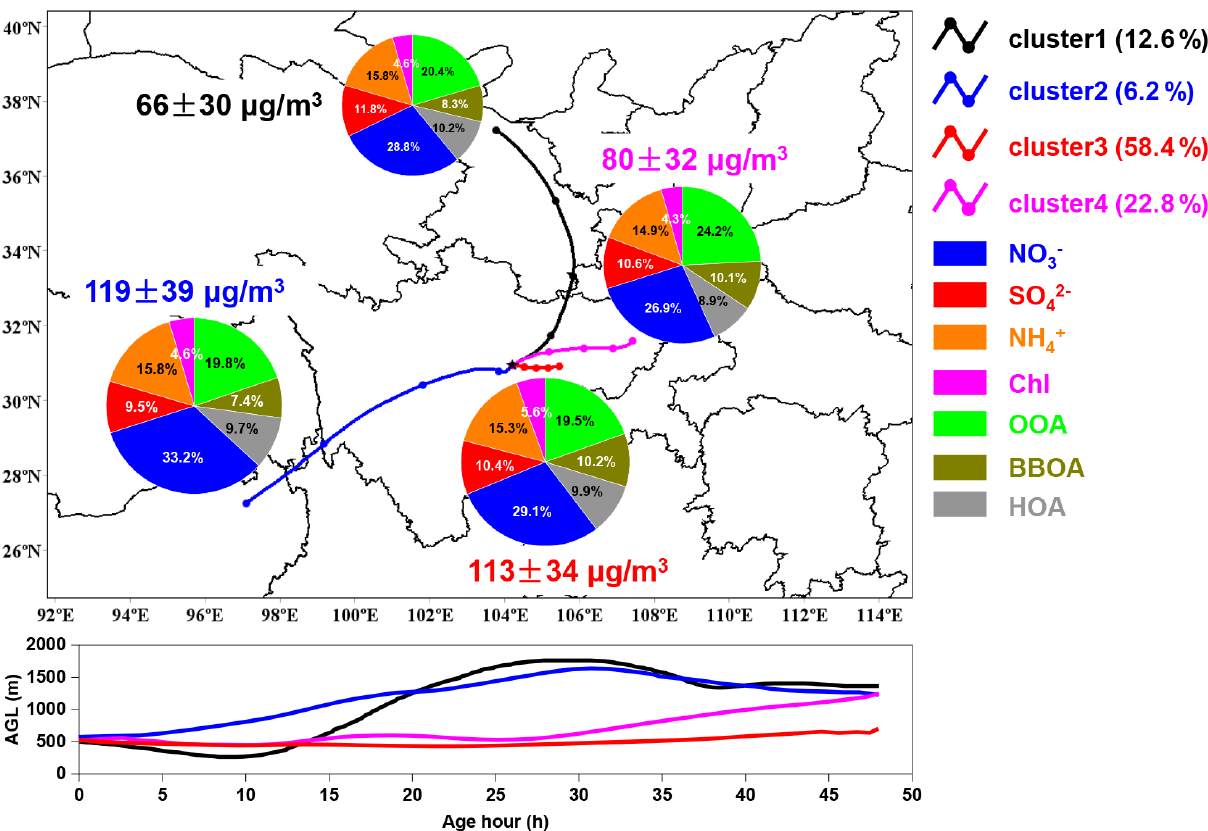
Figure 9. Simulation results of 48h backward air parcels cluster-mean trajectories during the campaign. The lines in black, blue, red and purple represent the mean trajectories of cluster 1 to cluster 4, respectively. The pie charts show the average mass contribution of different chemical compositions to PM 2 . 5 for each cluster. The lower panel shows the height profile (above ground level, AGL) for different air parcels clusters along their transport